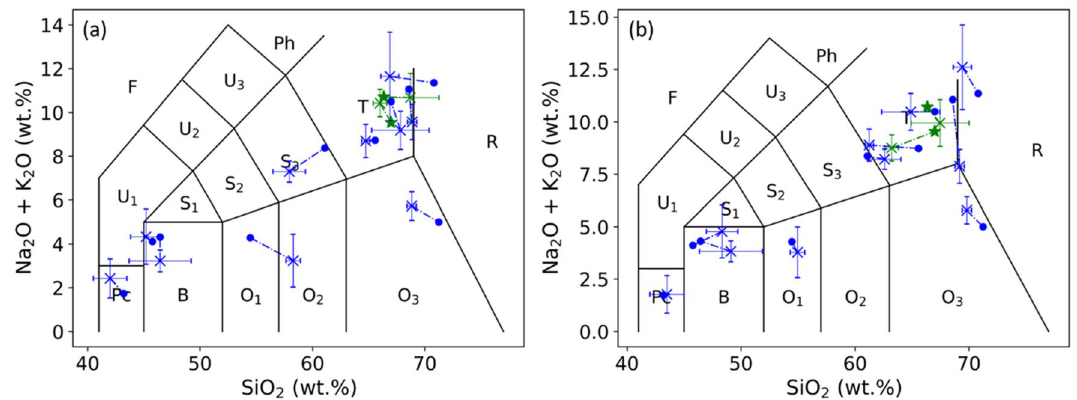
Figure 9. TAS classification using transfer learning models of the validation rock samples, ( a ) for polished rocks and ( b ) for raw rocks. The same symbols are used as in Fig.